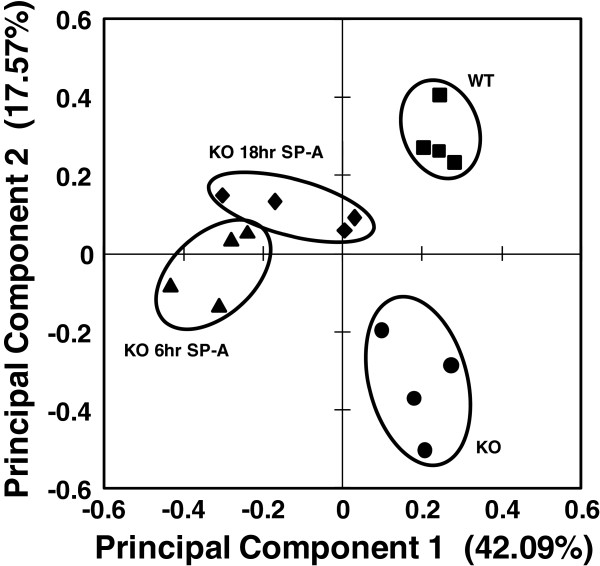
Principal component analysis of different treatment groups. A plot of the principal component analysis for the 172 significant (ANOVA, p < 0.05) protein spots is shown. The markers represent the weighted average for the first two principal components for the 172 proteins for each individual in each of the groups: SP-A knockout (KO) (·), SP-A knockout treated with SP-A for 6 hr (KO 6 hr SP-A) (▲), SP-A knockout treated with SP-A for 18 hr (KO 18 hr SP-A) (♦), and wild type (WT) (■).